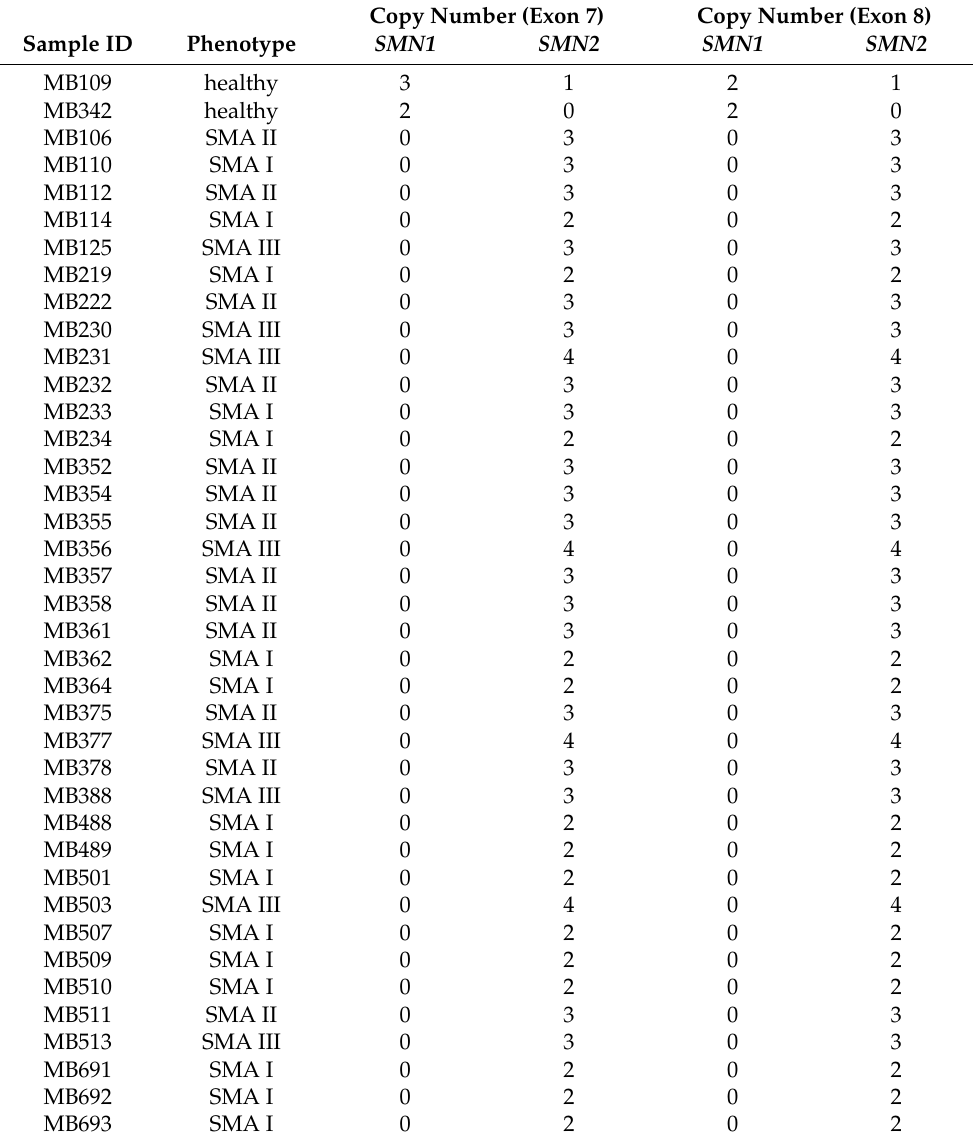
Table 2. Phenotypic and copy number information for samples within the MNDRL